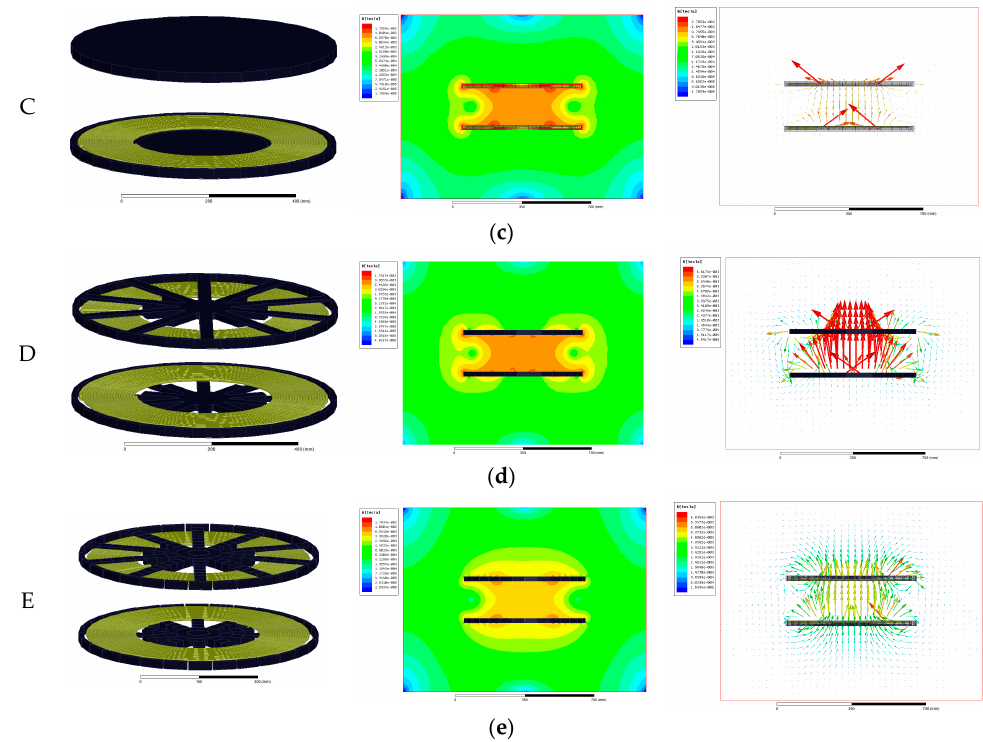
Figure 11. The coils with different ferrite cores, the magnetic flux distributions, and the magnetic line distributions. ( a ) A-without ferrite cores; ( b ) B-with a flat plate ferrite core; ( c ) C-with an “E” ferrite core; ( d ) D-with a hollow “E” ferrite core; and ( e ) E-with an improved hollow “E” ferrite core.